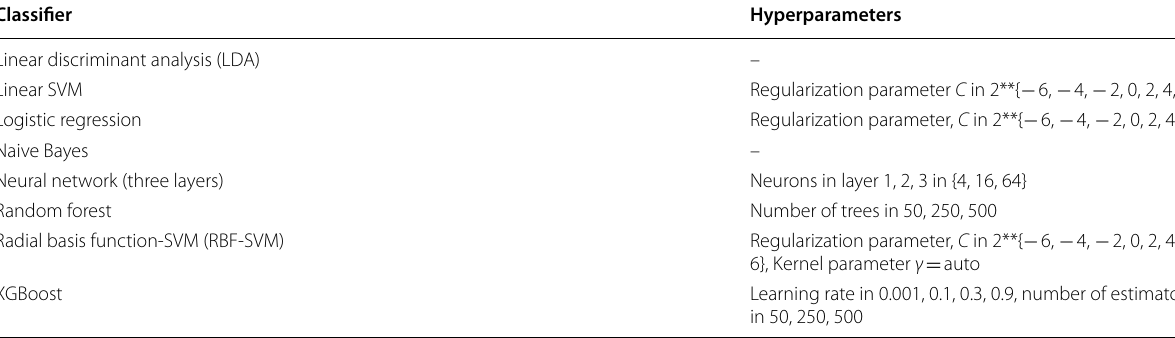
Filtering methods assign a score to each feature directly, while wrapper methods use a classifier Table 3 Overview of all classifiers used during